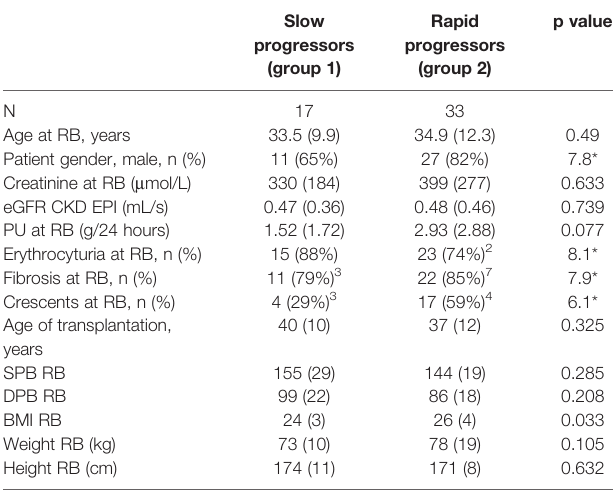
TABLE 4 | Age, gender, renal parameters, proteinuria, erythrocyturia, fi brosis, crescents, age of transplantation, blood pressure, BMI, weight, and height at the time of renal biopsy in two groups of patients with original diagnosis of IgAN after kidney transplant with graft failure.